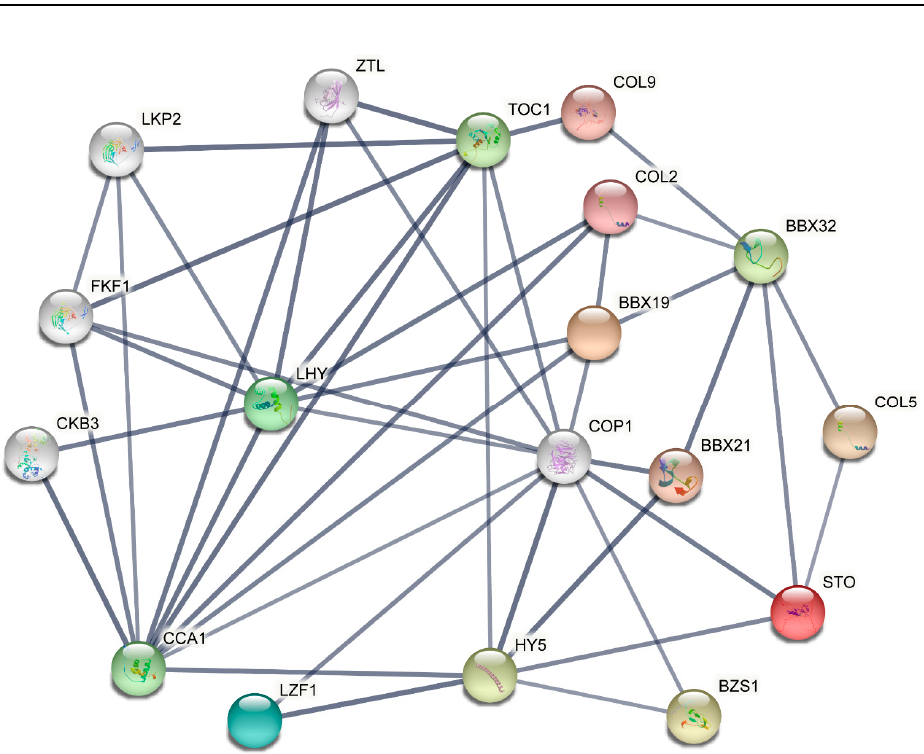
Figure 5. Protein–protein interaction networks of SmBBXs proteins. The thickness of the line reflects the strength of the interaction between the proteins.